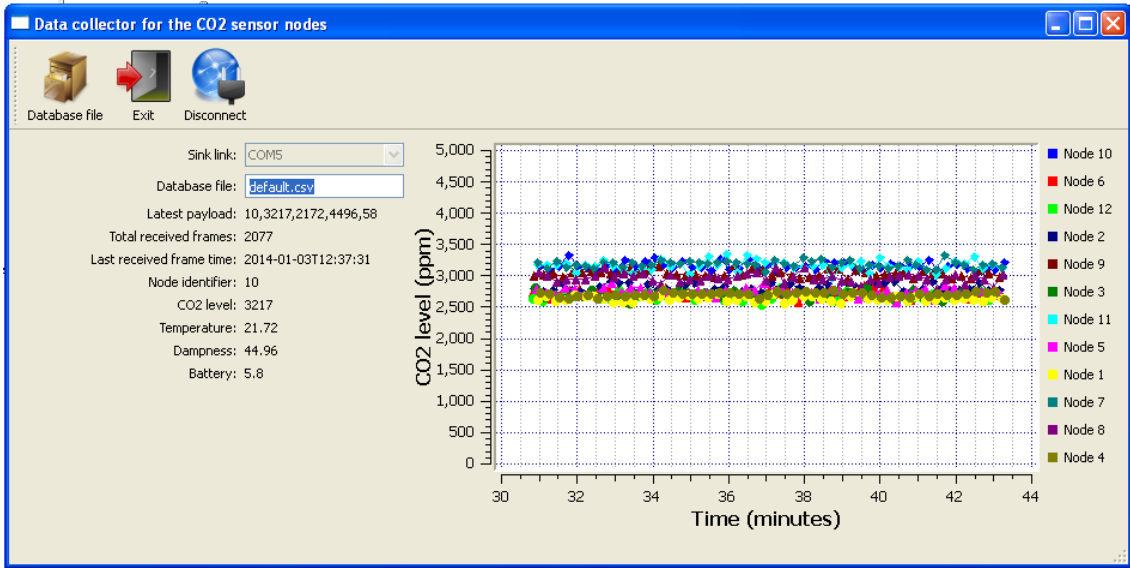
Figure 6. Data collection software